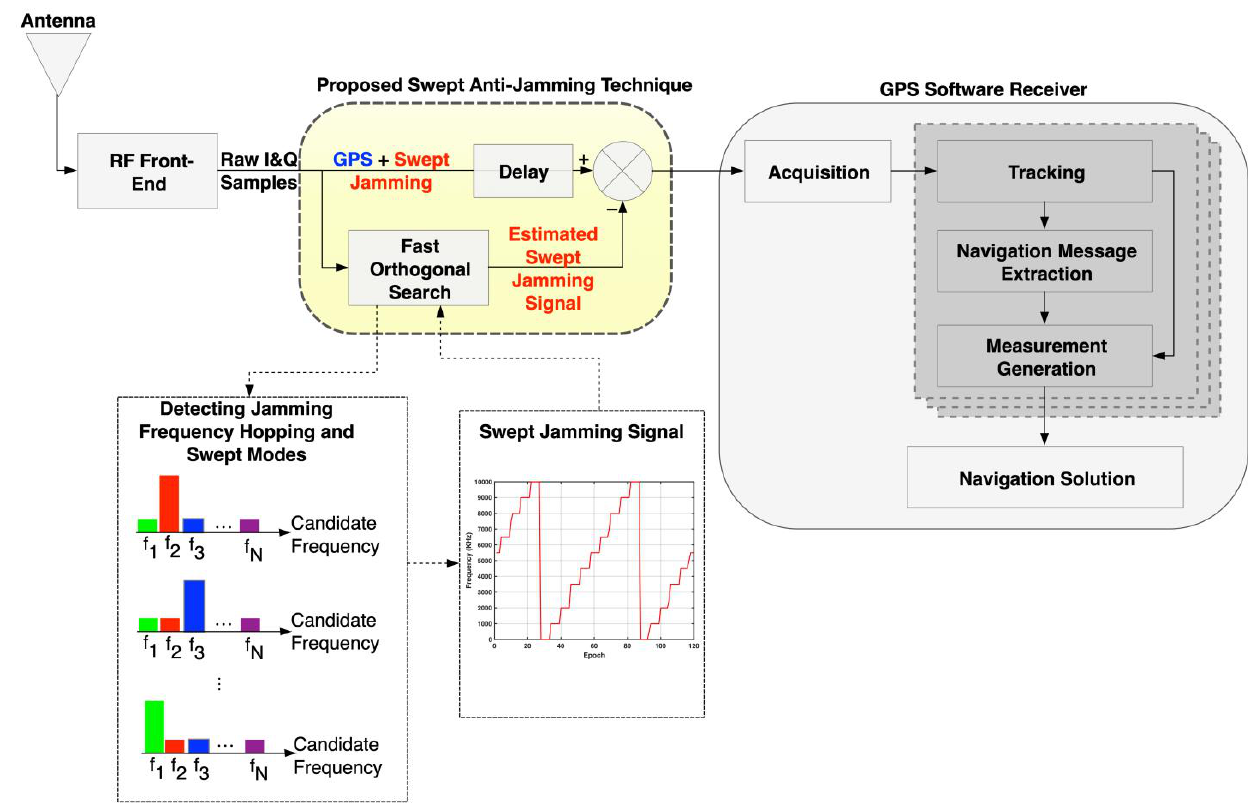
Figure 1. Structure of the proposed high-resolution pre-correlation anti-jamming technique.